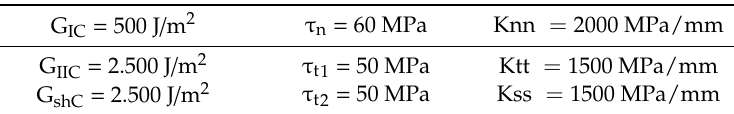
Table 3. Cohesive properties.